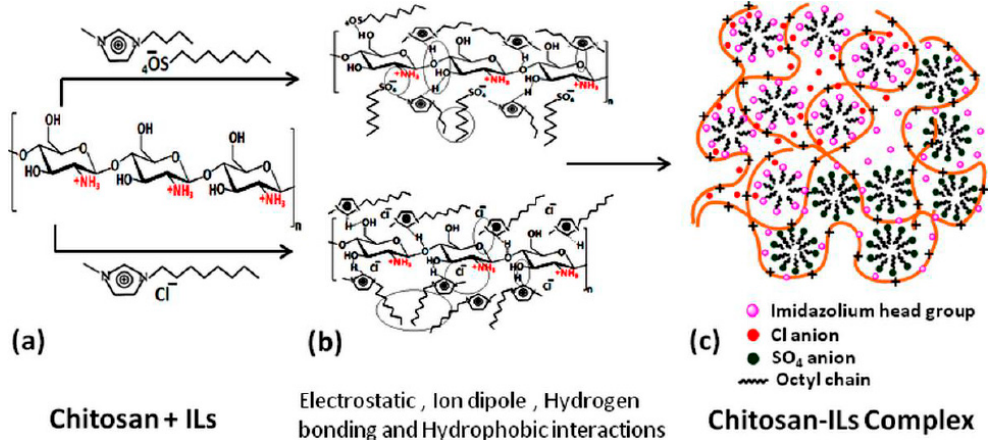
Figure 17. Schematic representation of the effect of surfactant anion on the formation of chitosan nanoparticles. Interactions of the chloride ion with the 1-octyl-3-methylimidazolium cations at the aggregate interface lead to the formation of larger aggregates. This is hindered in the case of the voluminous octyl sulfate anion [61]. Reprinted with permission from ref. [61]. Copright 2021 Elsevier.